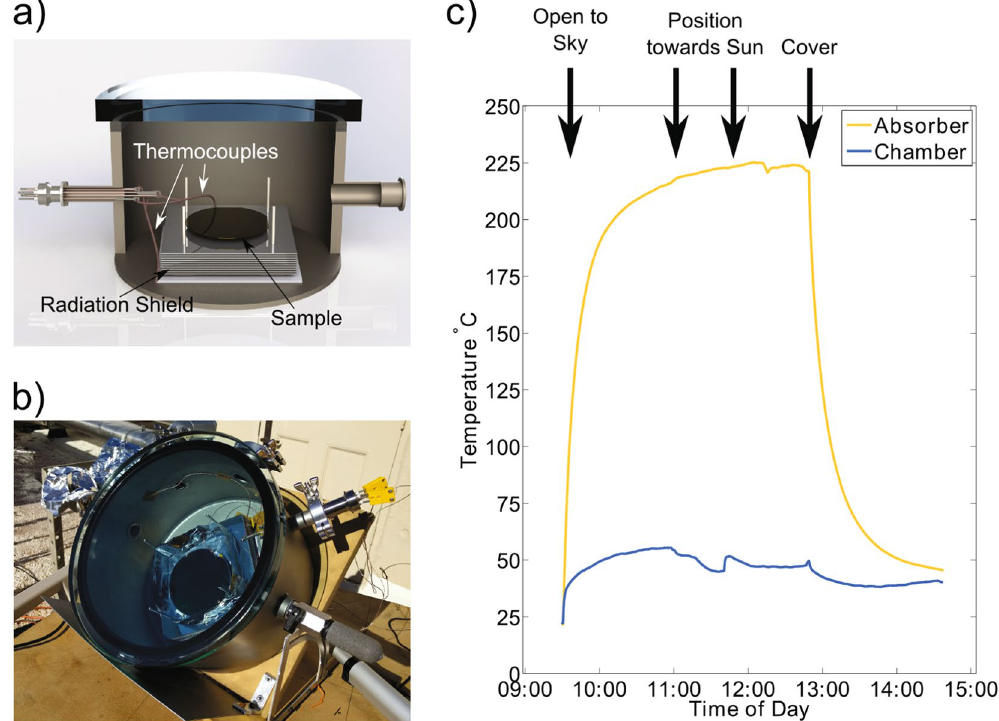
Figure 4. ( a ) Diagram of sample vacuum chamber and radiation shield. ( b ) Photo of vacuum chamber on the roof under solar insolation. ( c ) Sample surface temperature over the course of the day on Dec. 20, 2016 in Pasadena, CA. The temperature peaked at 225